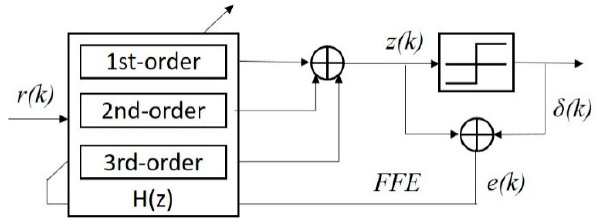
Figure 15. The structure of Volterra nonlinear equalizer (VNLE).